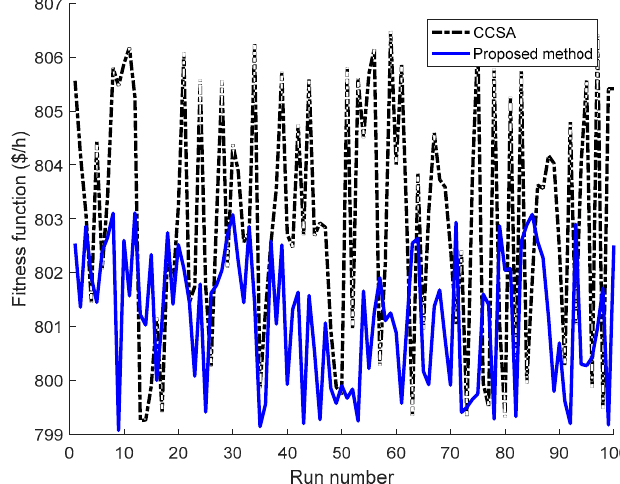
Figure 10. Fitness function of 100 runs obtained by the CCSA and proposed method in case 4.